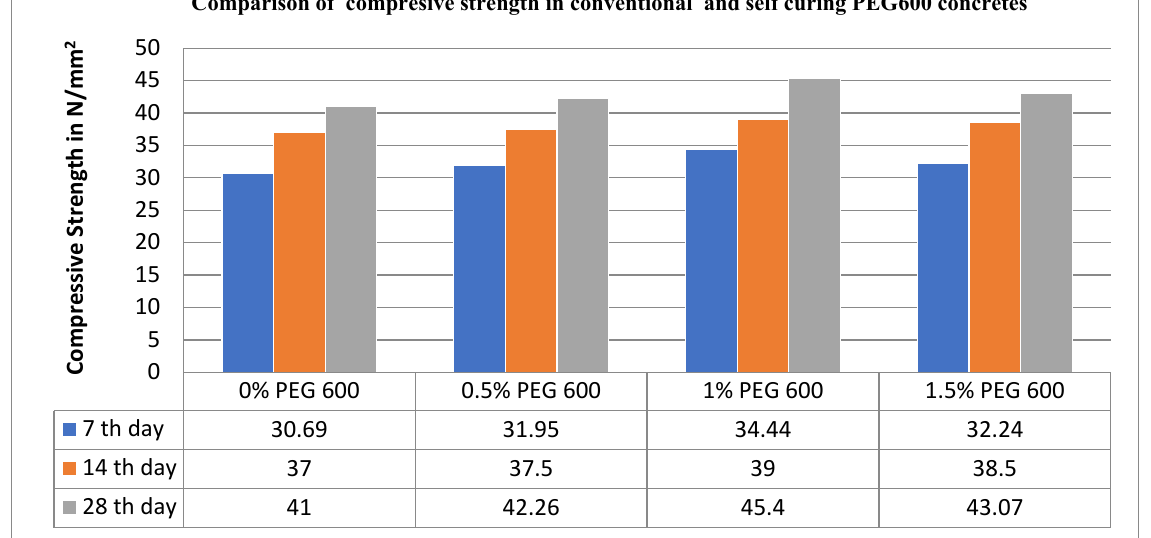
Figure 4. Comparison of compressive strength in conventional and PEG-600 concretes.